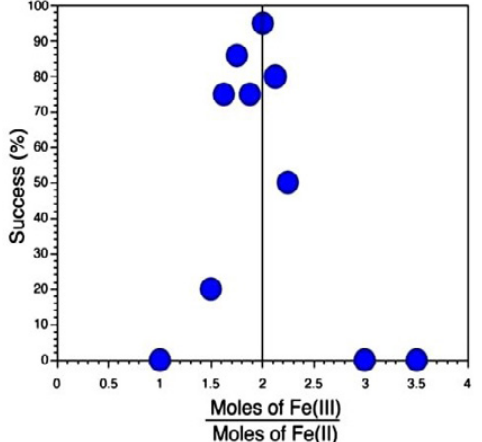
Fig. 1. Optimization of Fe 3+ / Fe 2+ ratio for production of Fe